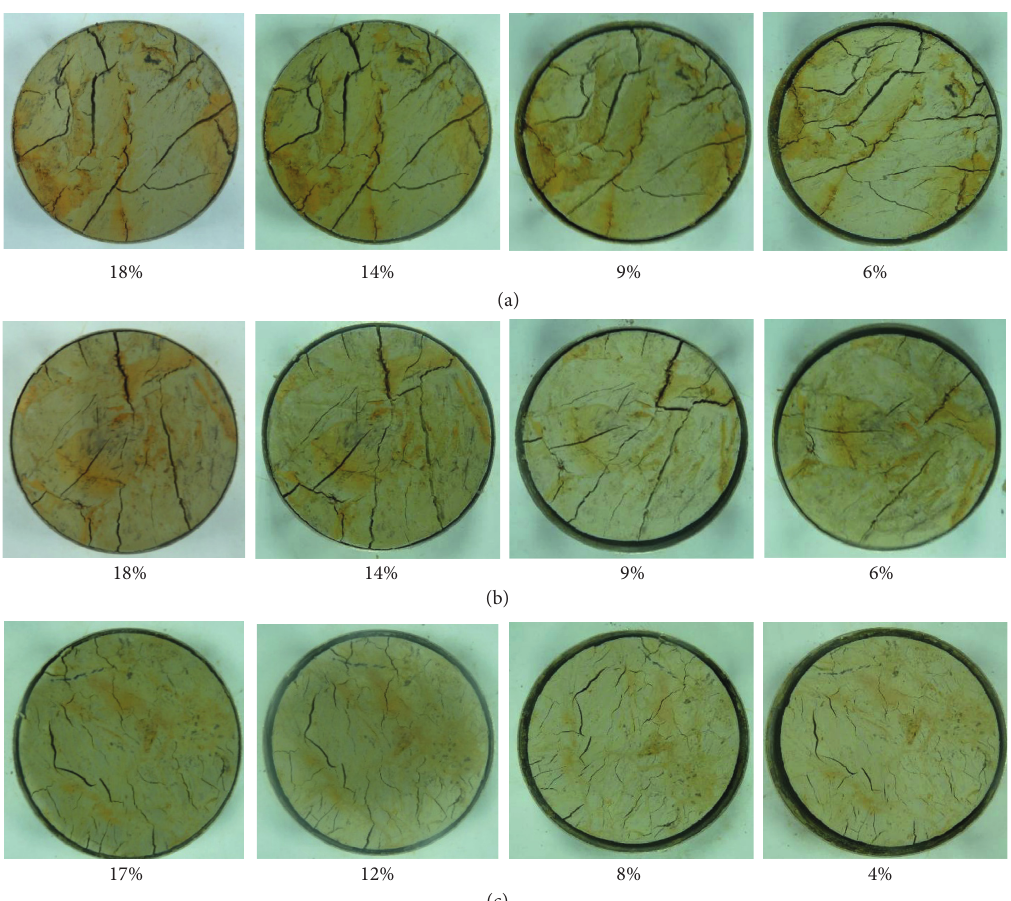
Figure 5: Crack development of sample with different humidity after one-time cyclic drying-wetting. (a) pH � 3, (b) pH � 5, and (c) pH �